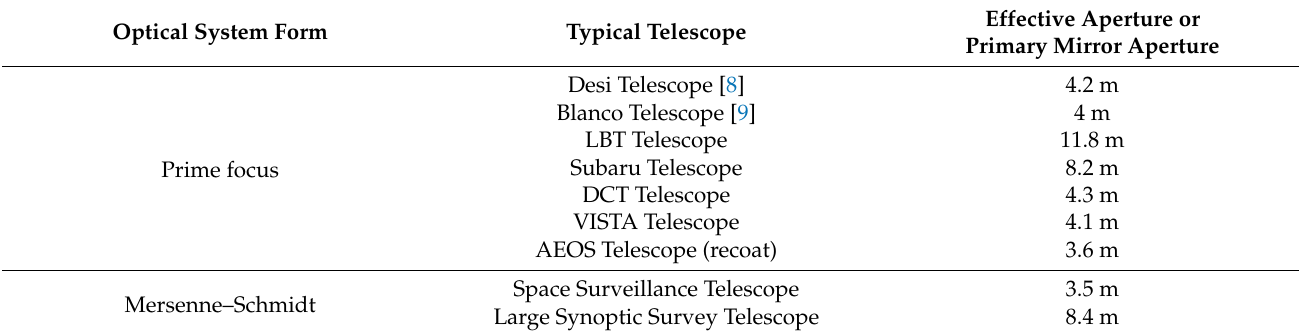
Effective Aperture